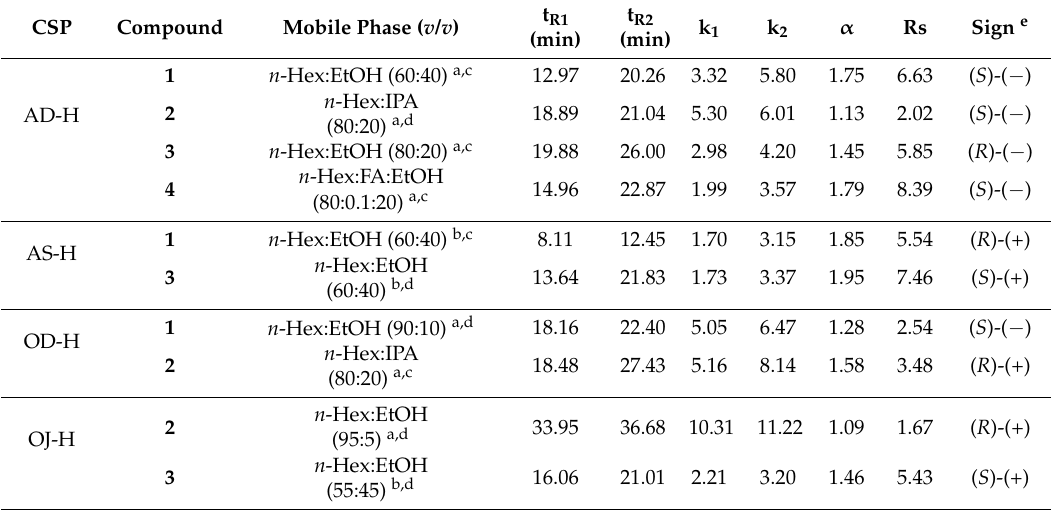
Table 1. Comparison of sulfoxide drugs on chiral